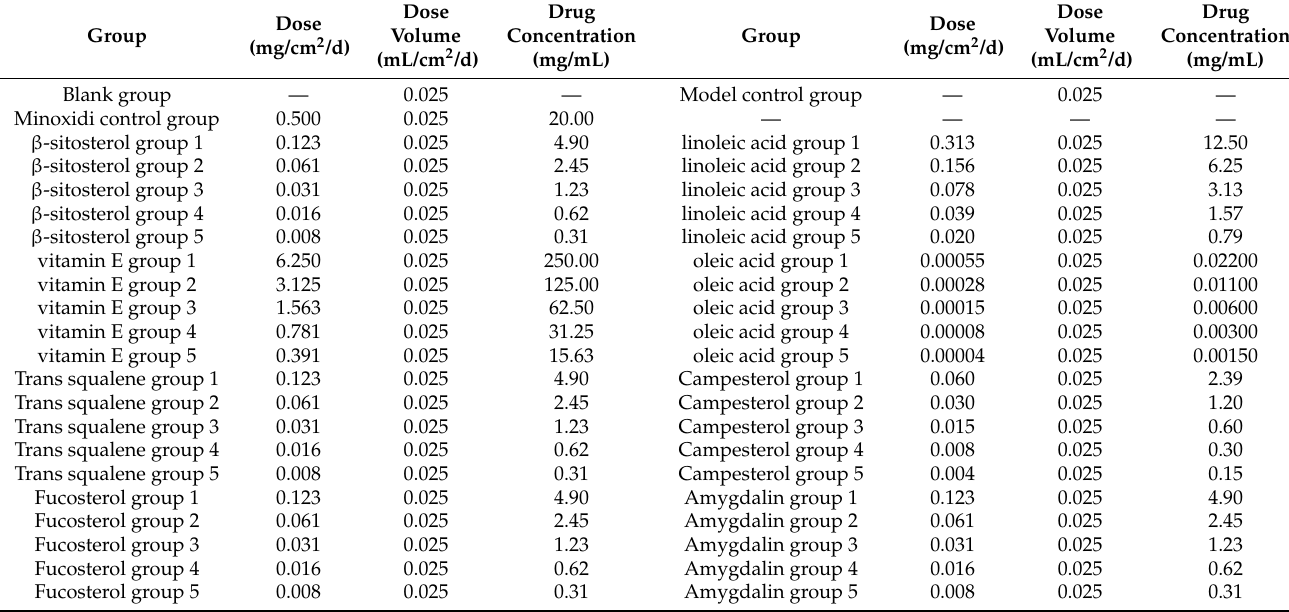
Table 2. Drug group and dosage table of KM